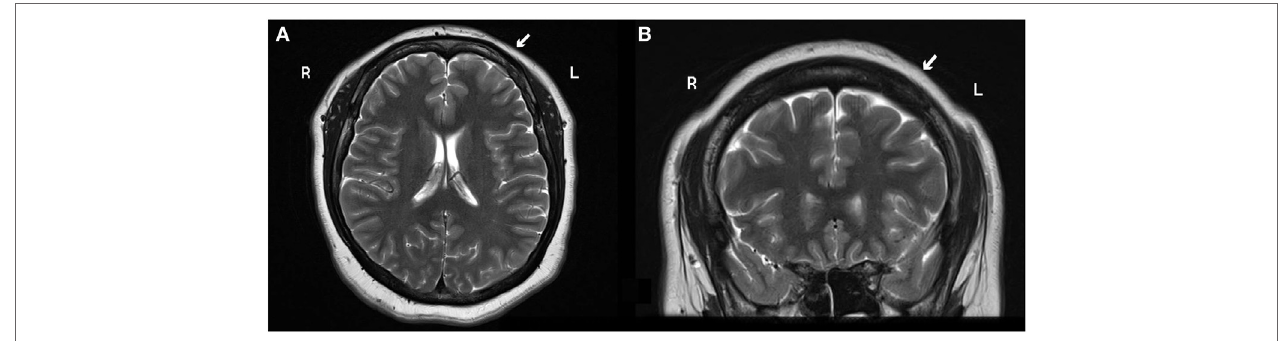
FIgURe 1 | (a) Axial and ( B) coronal 3 T MRI head scan shows blurry cortical gray and white matter on the left frontal lobe suggestive of focal cortical dysplasia (white arrow). Abbreviations: R, right; L,